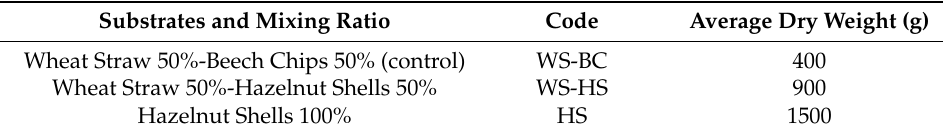
Table 1. Composition and ratios of the substrates used in cultivation trials. Substrates and Mixing